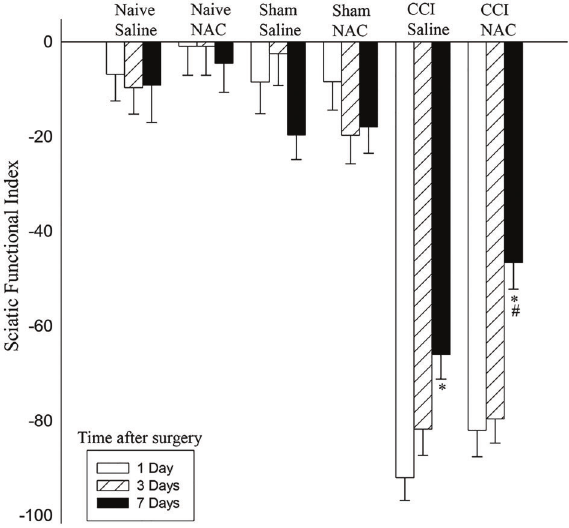
Figure 2. Functional recovery assessed by the Sciatic Functional Index (SFI) in rats with chronic constriction injury (CCI) of the sciatic nerve that received 2, 4, or 8 intraperitoneal injections of saline or N-acetylcysteine (NAC; 150 mg (cid:1) kg – 1 (cid:1) day – 1 ) beginning 4 h after CCI. Rats were sacri fi ced 1, 3, and 7 days after surgery. On the Y axis, the results are reported in units, and 0 indicates normality and – 100 the total absence of functionality. Data are reported as means ± SE. *P o 0.05 compared to CCI group at day 1; # P o 0.05 compared to saline-treated CCI group at day 7 (three-way ANOVA followed by Tukey post hoc